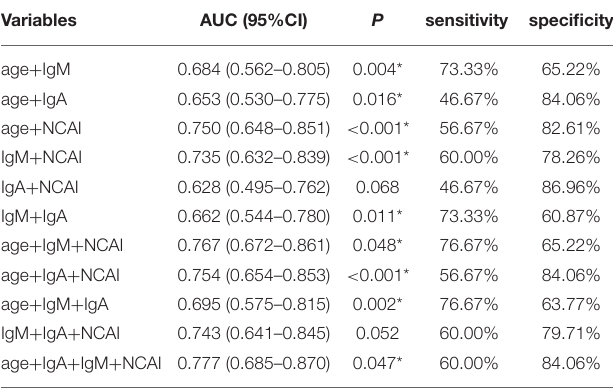
TABLE 5 | Combined diagnosis of the risk